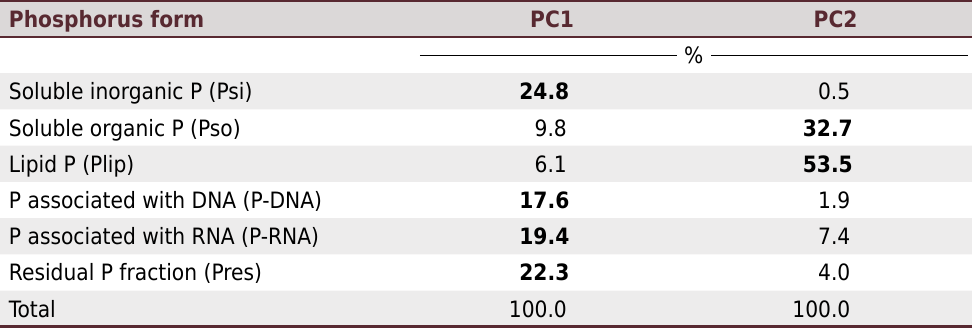
Table 2. Contribution of the variables for the first two principal components